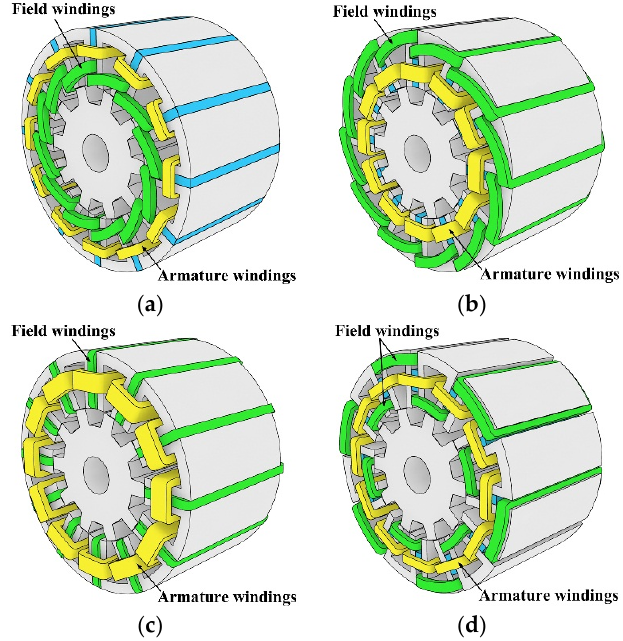
Figure 2. 3D configurations of the 12 ‐ stator ‐ slots/10 ‐ rotor ‐ poles HEFS machines. ( a ) PM ‐ top; ( b ) PM ‐ bottom; ( c ) PM ‐ middle ‐ 1; ( d ) PM ‐ middle ‐ 2.